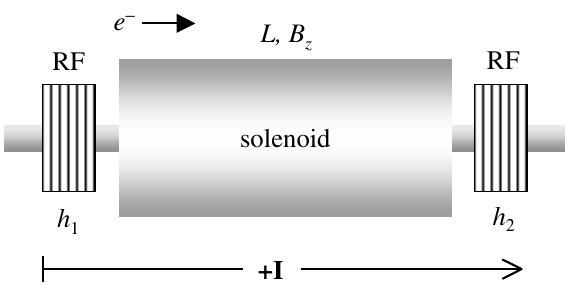
FIG. 1. One-phase electron beam conditioner composed of a solenoid magnet sandwiched between rf accelerating sections operated at opposing zero-crossing